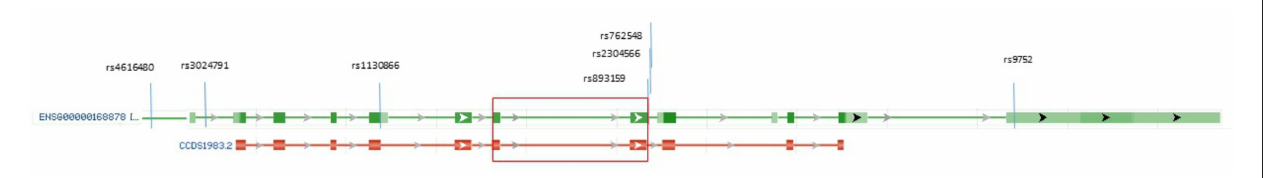
FIGURE 1 | The reference transcript for the SFTPB gene (green section) and the SP-B preprotein (red section). The SFTPB gene reference transcript ENSG00000168878 is composed of 11 exons, with dark green rectangles aligning the exons that encode the SP-B preprotein, which is composed of 381 amino acid residues (CCDS1983.2, red section below transcript). The mature SP-B protein contains amino acid residues at codons 201 to 279 (28, 29), and protein-encoding exons 6 and 7 are indicated by a large red rectangle. Three of the tagged SNPs (rs893159, rs2304566, and rs762548) are in the second exon encoding mature SP-B, and SNP rs9752 is at 3 ′ UTR in the flanking arm of the preprotein (light green transcript rectangle). https://www.ncbi.nlm.nih.gov/gene/6439 (modified).